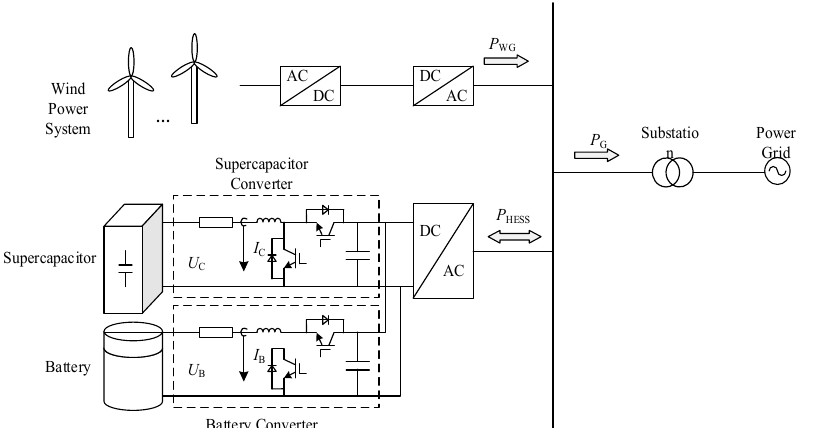
Figure 3. Block diagram of wind ‐ storage cogeneration system .